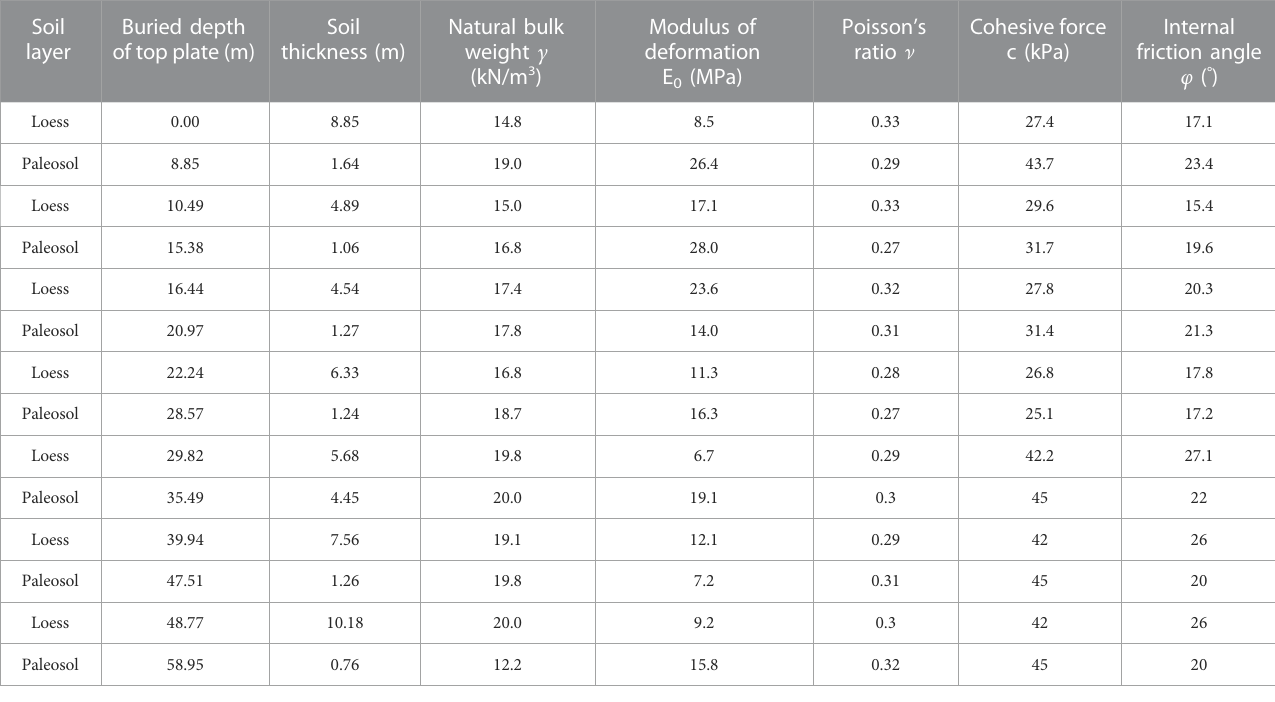
TABLE 2 Soil properties of loess tableland.